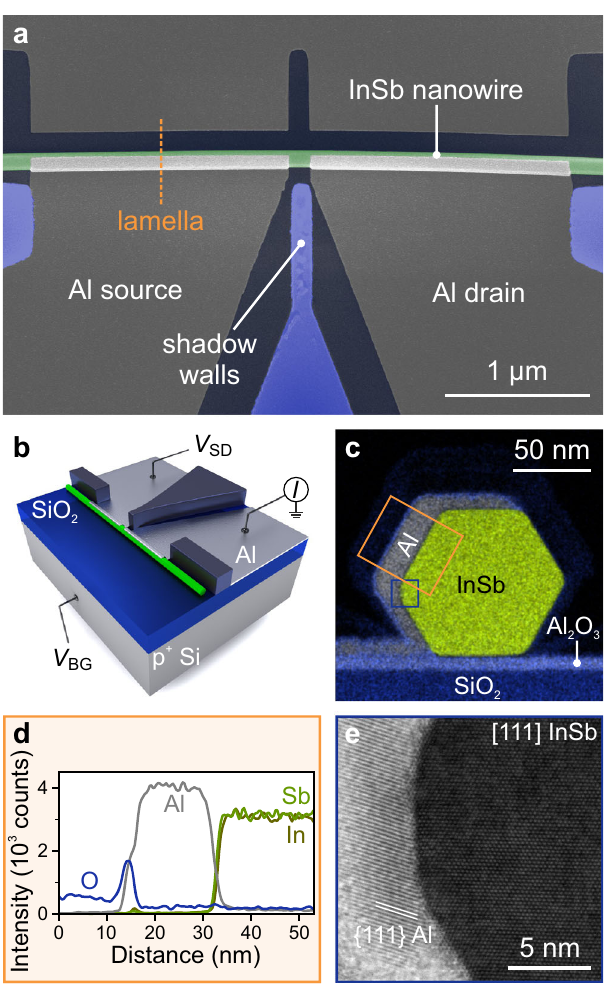
Fig. 3 Multiple Andreev re fl ections and supercurrent in InSb/Al Josephson junctions. a Differential resistance, R , as a function of I SD (upward sweep direction) and T for device 1 at V BG = 13.65 V. The switching current reaches a maximum of ~ 90 nA at T = 30 mK and persists up to 1.8 K. The peaks at I SD > I sw arise from quasiparticle transport via multiple Andreev re fl ections. b Conductance line traces (red) versus source – drain voltage for device 1 at V BG = 5.1 V (top) and for device 2 at V = 3.0 V (bottom). The theoretical fi ts (green) yield the transmissions, BG T n , of the one-dimensional subbands with index n : T = 0.91, T = 0.17 (top) 1 2 and T 1 = 0.93, T 2 = 0.71, T 3 = 0.01 (bottom). c Differential conductance, G , as a function of V SD and magnetic fi eld, B ∥ , which is oriented along the nanowire, for device 2 at V BG = − 0.9